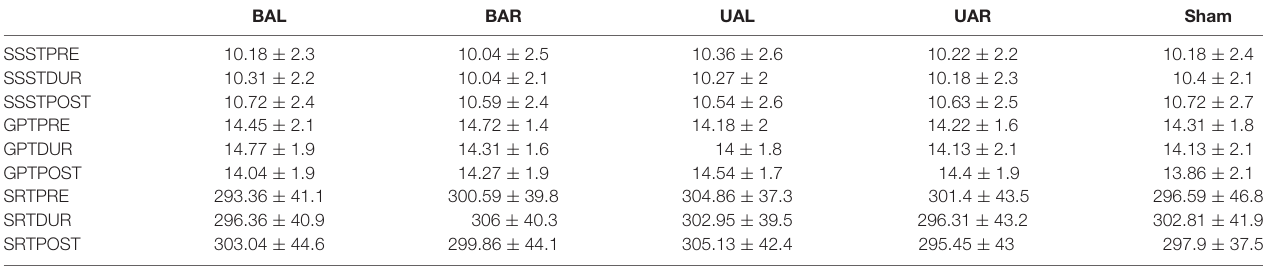
TABLE 1 | Single-task performance: number of pegs inserted [Grooved Pegboard Test (GPT)] and number of correct subtractions [Serial Seven Subtraction Task (SSST)] within 30 s before (PRE), during (DUR) and 30 min after (POST), unilateral (Ul), bilateral (Bl) and sham transcranial direct current stimulation (tDCS) of left (AL) and right (AR) dorsolateral prefrontal cortex (DLPFC). Simple reaction time (SRT), before, during and after tDCS in all five montages.